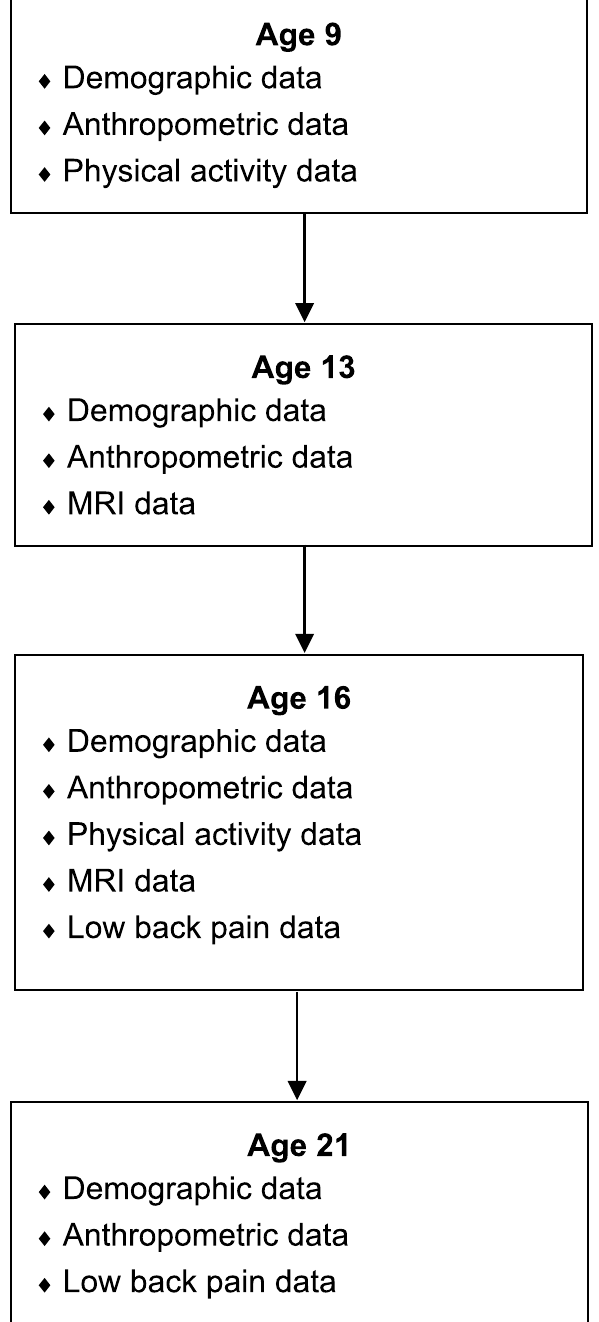
Figure 1. Data collection time-points for the physical activity, muscle morphology, and low-back pain